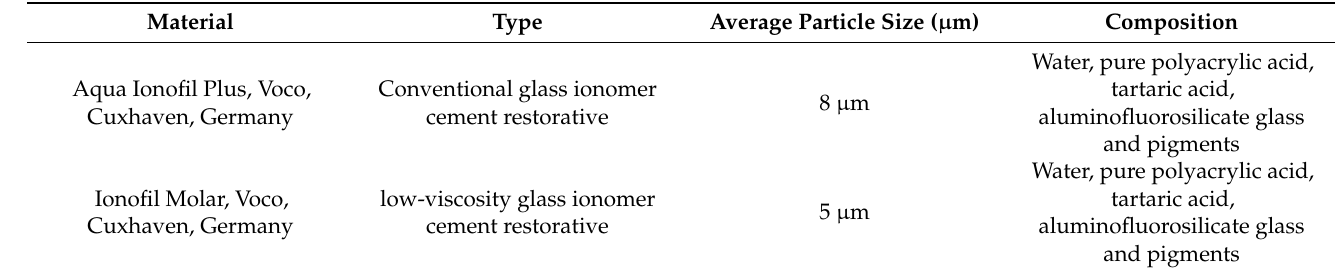
Table 1. Materials 1 investigated in this